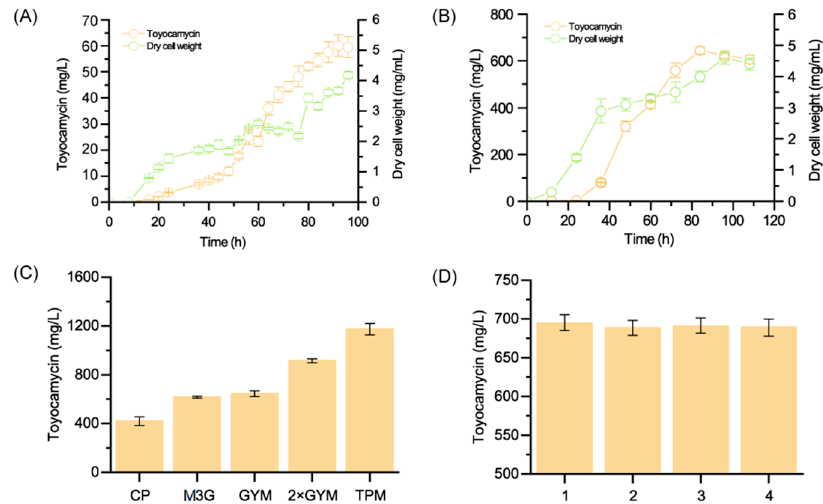
Figure 1. The comparison of toyocamycin production by wild-type and R3-33. The antibiotic production and dry cell weight in wild-type ( A ) and R3-33 ( B ) from 0 h to 96 h in GYM medium at 28 °C; ( C ) the toyocamycin production in different medium; ( D ) the production stability of R3-33 in four rounds of generation.